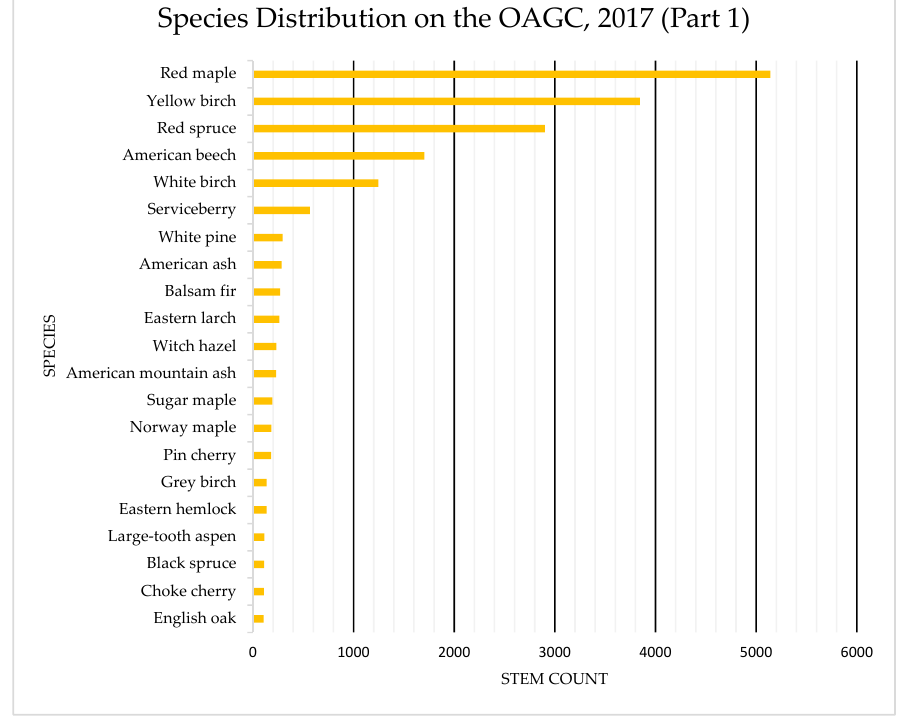
Figure A1. Total tree species distribution on OAGC, 2017 (higher frequency) based on plot projections made using the area of forested patches. Forests 2020 , 11 , x FOR PEER REVIEW